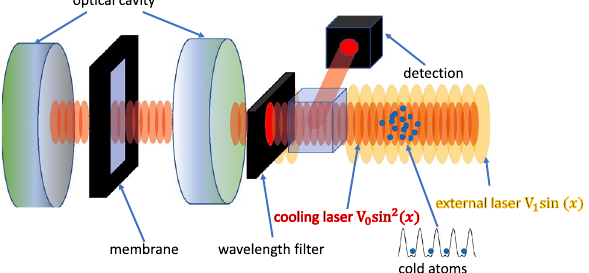
Figure 1. The scheme of the hybrid atom-optomechanics system. The cold atoms are trapped by two lasers and only one of them is filtered to enter a cavity where it is coupled to a mechanical